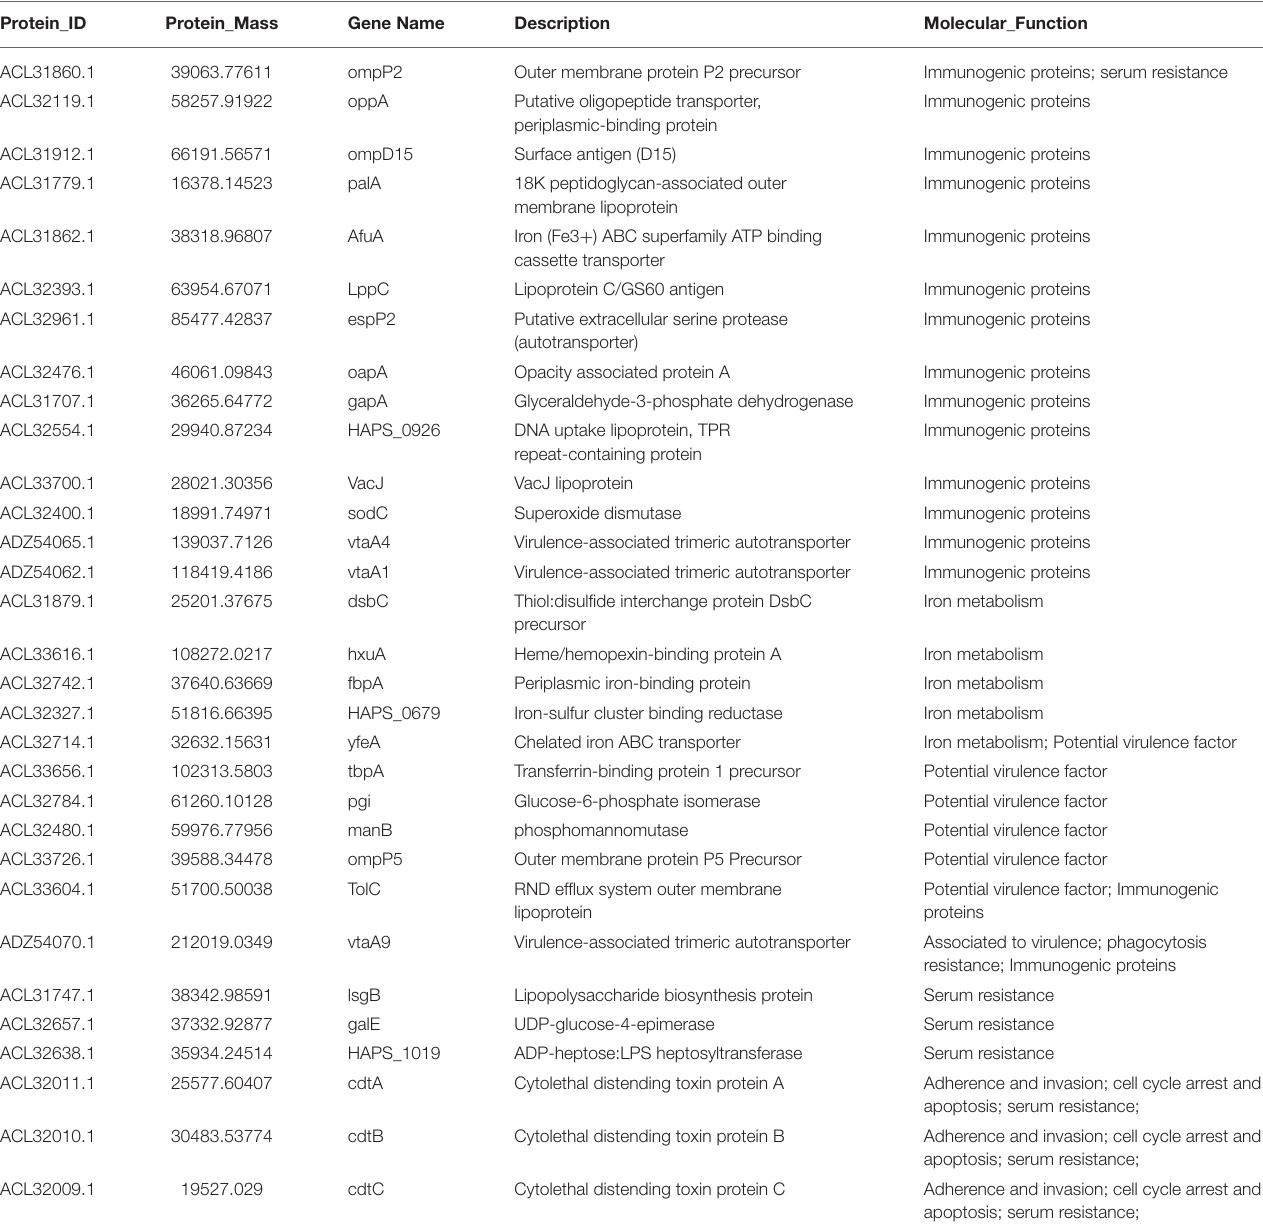
TABLE 1 | Major proteins identified from OMVs of H. parasuis H45